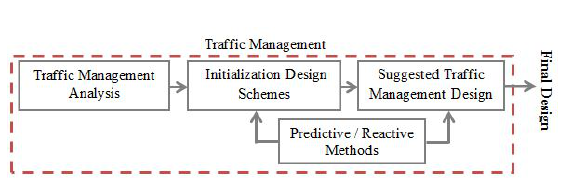
Fig. 2. Traffic management